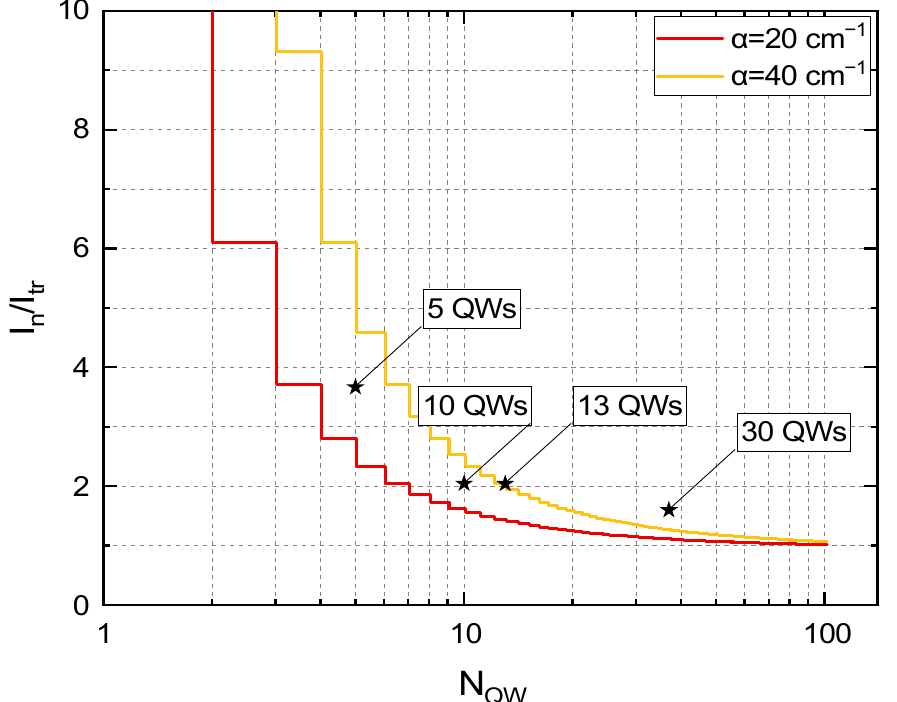
Figure 4. Threshold intensities for different number of quantum wells (N QW ) in the active core divided by transparency intensity (I tr = c n tr ) at T = 150 K. Solid lines: calculations for two values of absorption coefficient α , symbols: experimental values for structures with 5, 10, 13 and 30 quantum wells (QWs).